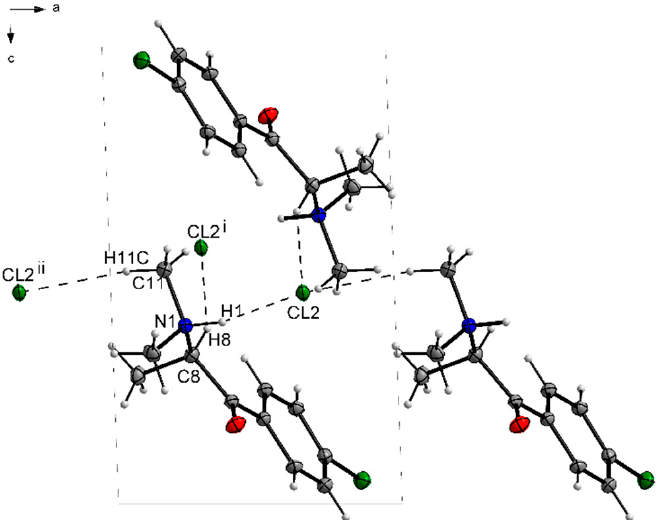
Figure 4. Part of the crystal structure of Compound 1 viewed along the b axis, showing H-bonding between neighboring ions (dashed lines). Symmetry codes: (i) − x + 1, − y + 1, − z + 1; (ii) x − 1, y , z .